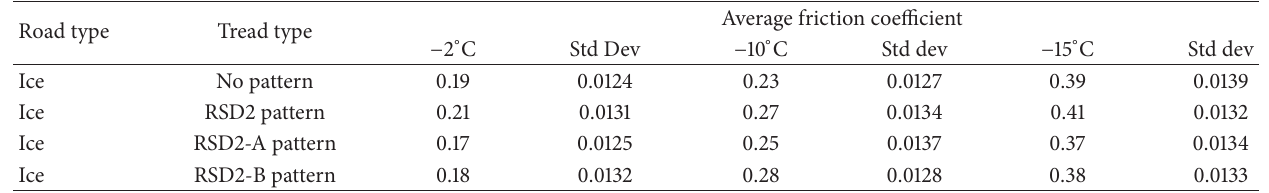
Table 3: Average friction coefficients between ice and tread.